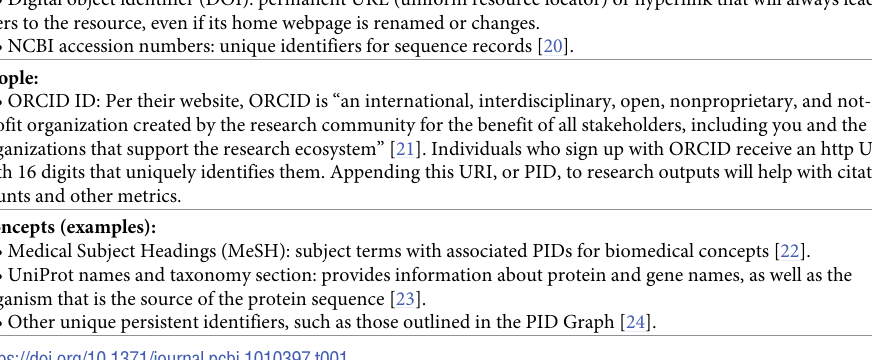
Table 1. Commonly used PIDs in research